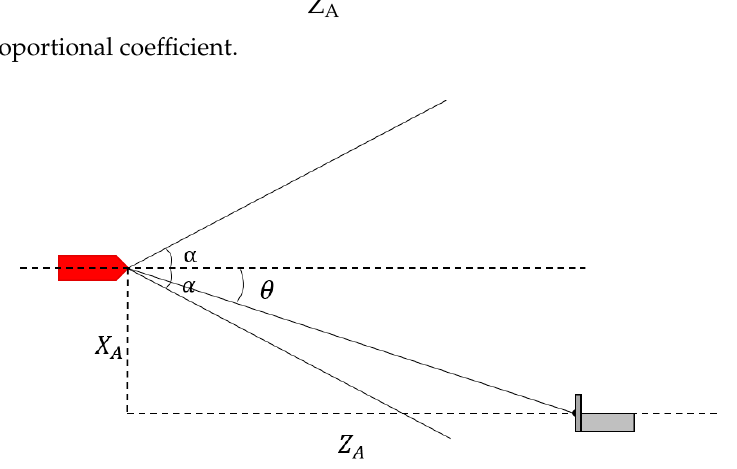
Figure 13. Schematic of AUV on the horizontal plane.